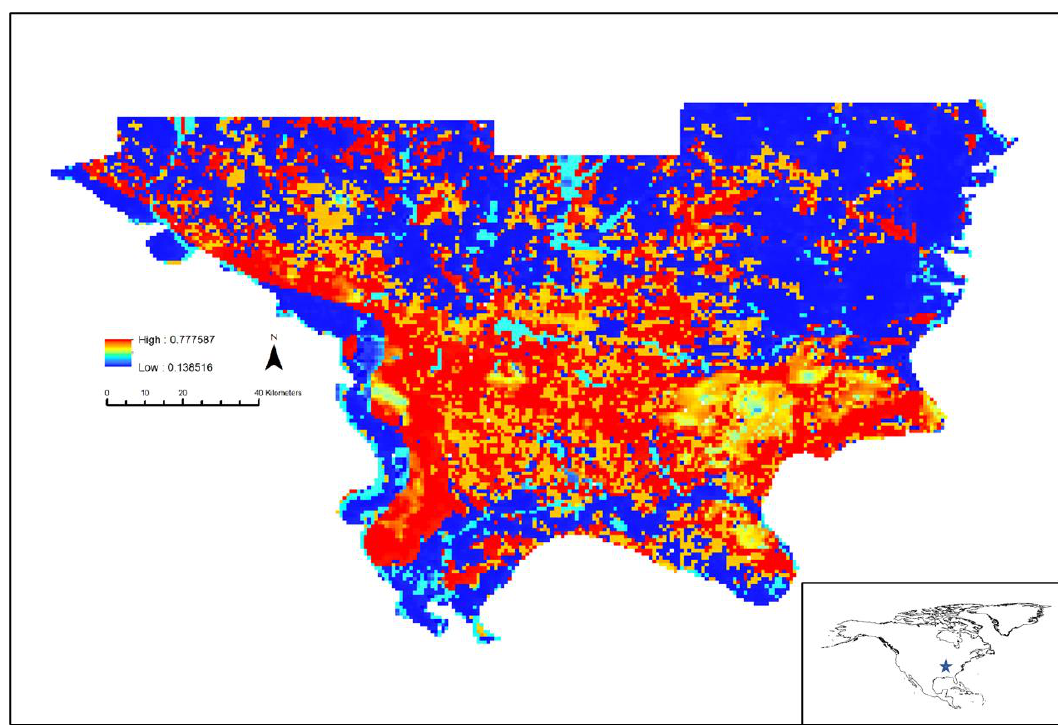
Figure 3. Spatial distribution model of predicted striped skunk presence in southern Illinois based on striped skunk occurrences collected during January to April 2008 – 2010 and April 2018 – March 2020. Predicted presence score ranges from 0.0 (low) to 1.0 (high).